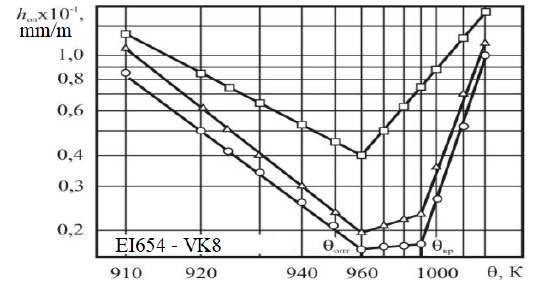
Fig. 4. Relative linear wear versus temperature when turning with different accelerations (S = 0.1 mm / rev; t = 0.5 mm) ∆ - av <0; - av = 0; - av>